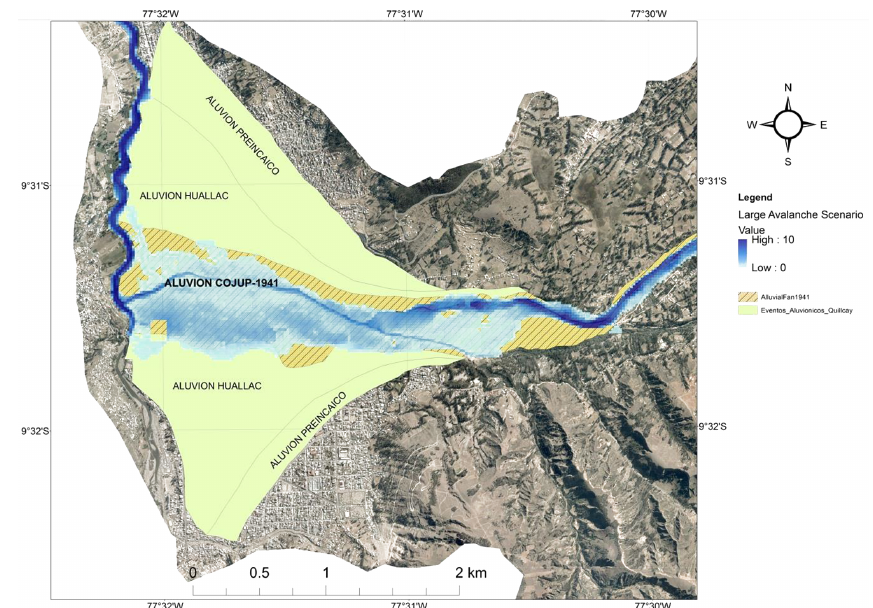
Figure 11. Maps published by INDECI (2003) indicating the extension of past mudflow events with the large avalanche scenario superim- posed on top of